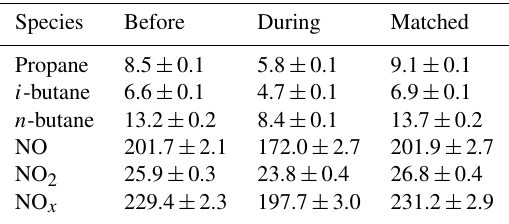
Table 3. Mixing ratios of LPG-related VOCs and NO x during the period before the program, the matched period and the period during the program (unit: